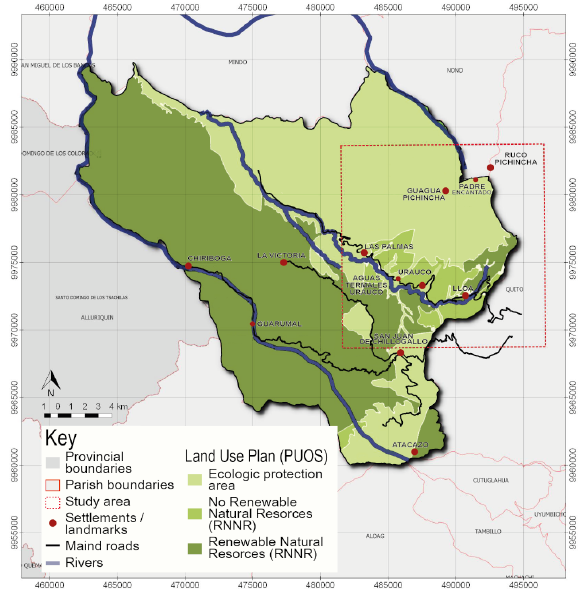
Figure 3: Land use